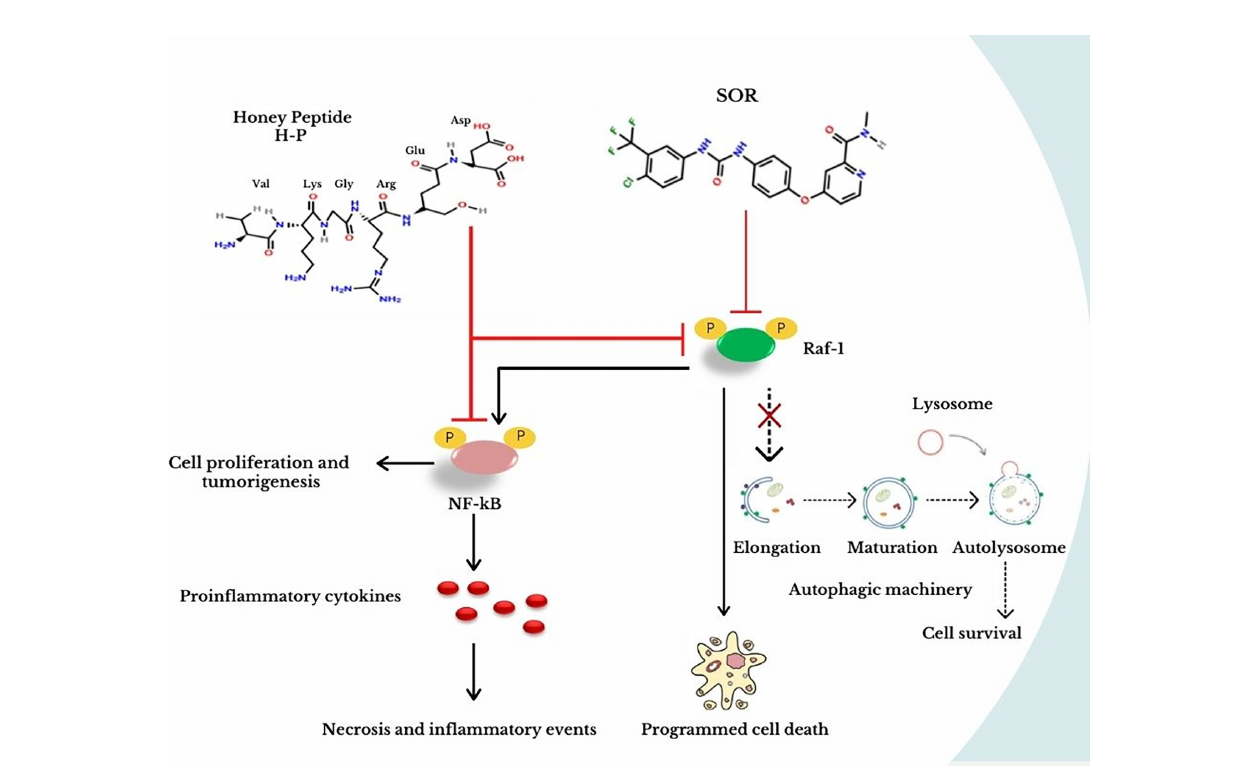
FIGURE 6 | Effective targeting of NF-kB and Raf-1 activation by the novel extracted H-P. In breast cancer cells, SOR treatment inhibits the Raf-1 activity, which prevents the autophagic machinery and stimulates programmed cell death. As a result of this protocol, the secretion of proin fl ammatory cytokines is increased causing necrotic events and activating NF-kB, which is responsible for cell proliferation and tumorigenesis. In contrast, the treatment of H-P extract can disturb the activity of both Raf-1 and NF-kB, which ensures the best results without detectable cytotoxic effects in normal mammary cells when treating breast